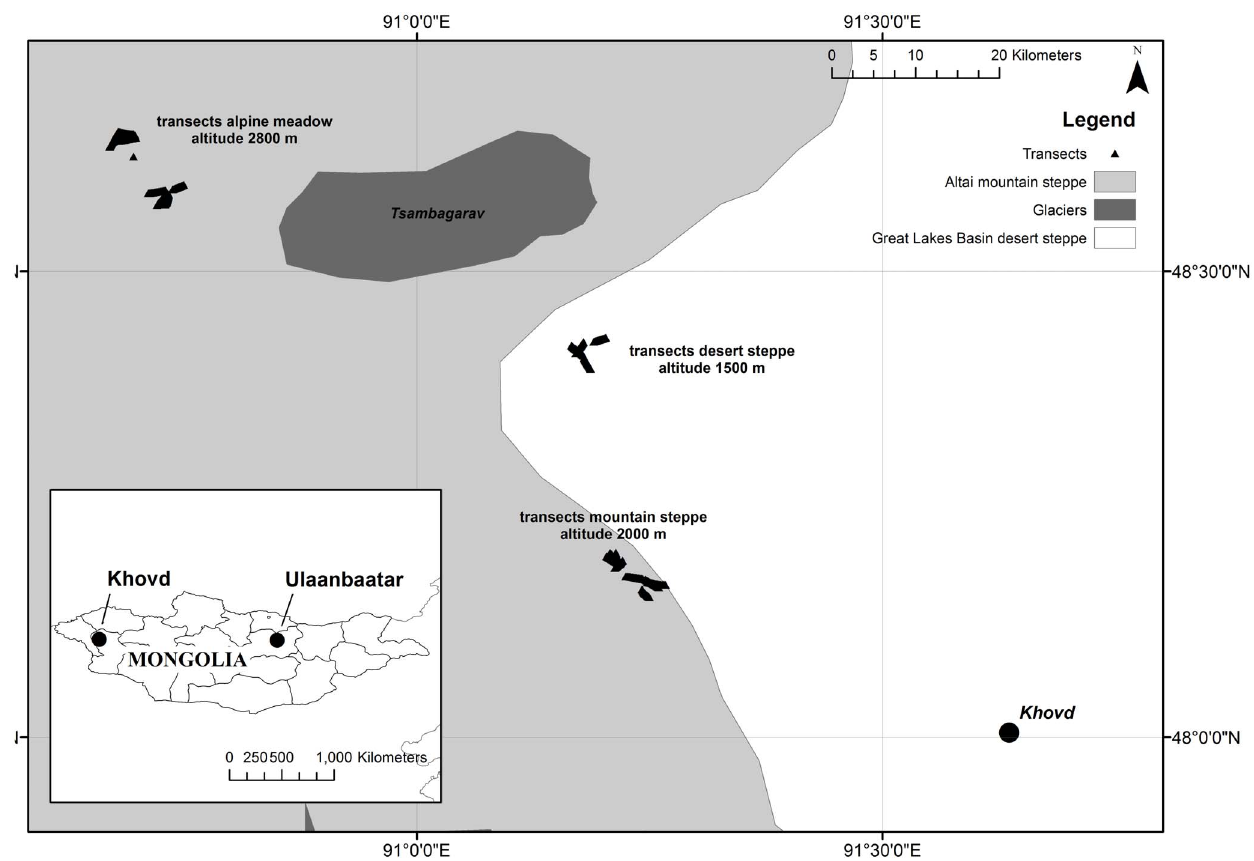
Figure 1. Study area in the northwest of Khovd City. Study sites at desert steppe in the area of the Great Lakes Basin, alpine region close to mount Tsambagarav and mountain